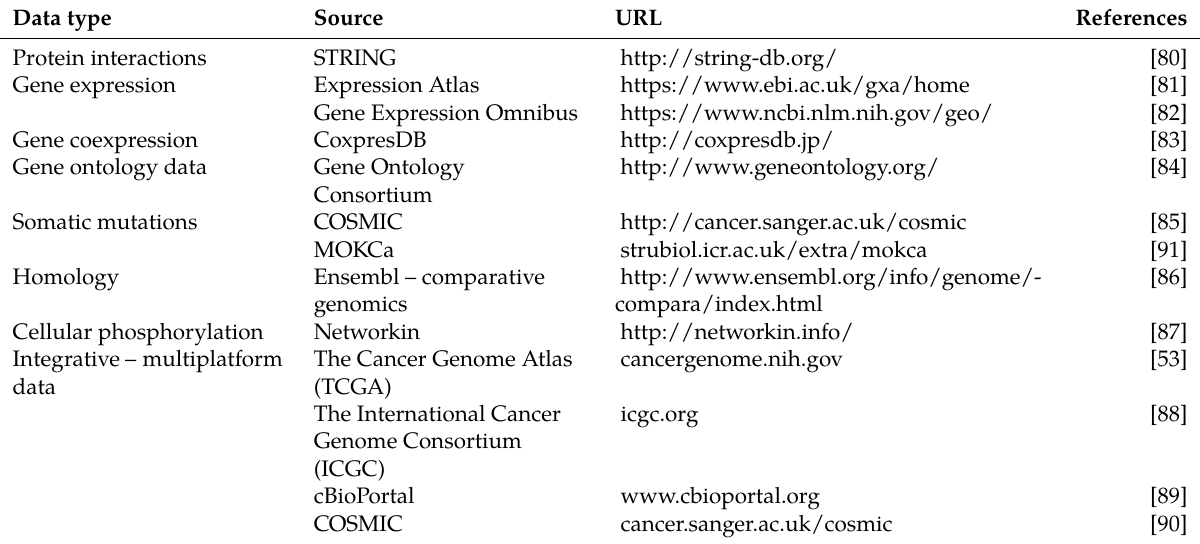
Table 1: List of useful data sources of training data for genetic interaction